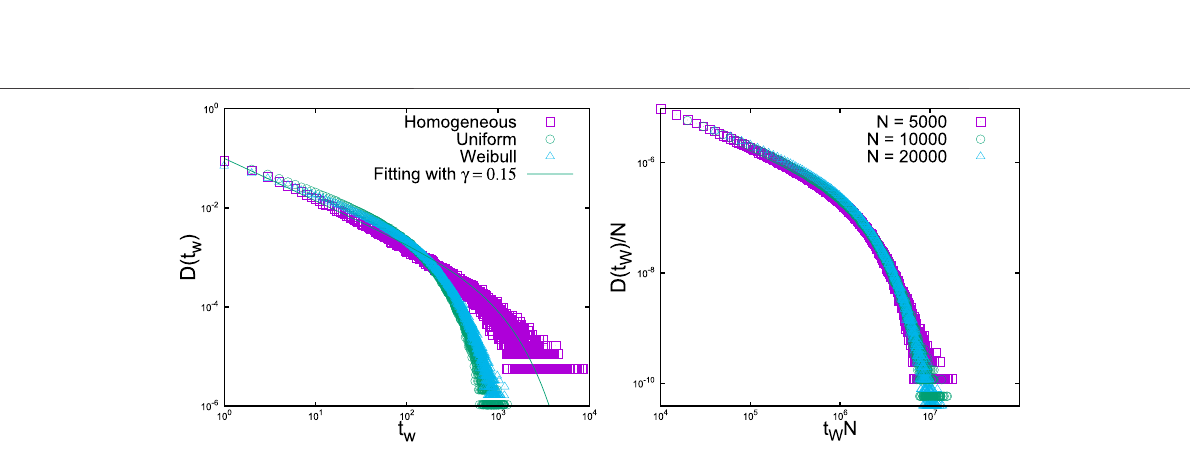
FIGURE9|Left: Thesimulationresultsforthewaitingtimedistributionsforthreedifferenttypesof fi berstrengthdistributions,with N (cid:1) 20000.Allthecurvescanbe fi ttedwiththeGammaformexp (− t / a ) / t 1 − c c (cid:1) 0 . 15isforthehomogeneouscaseand c (cid:1) 0 . 26isforuniformandWeibulldistributions. Right: weshowthedata W W ,where collapse of the waiting time distributions with system sizes for uniform fi ber strength